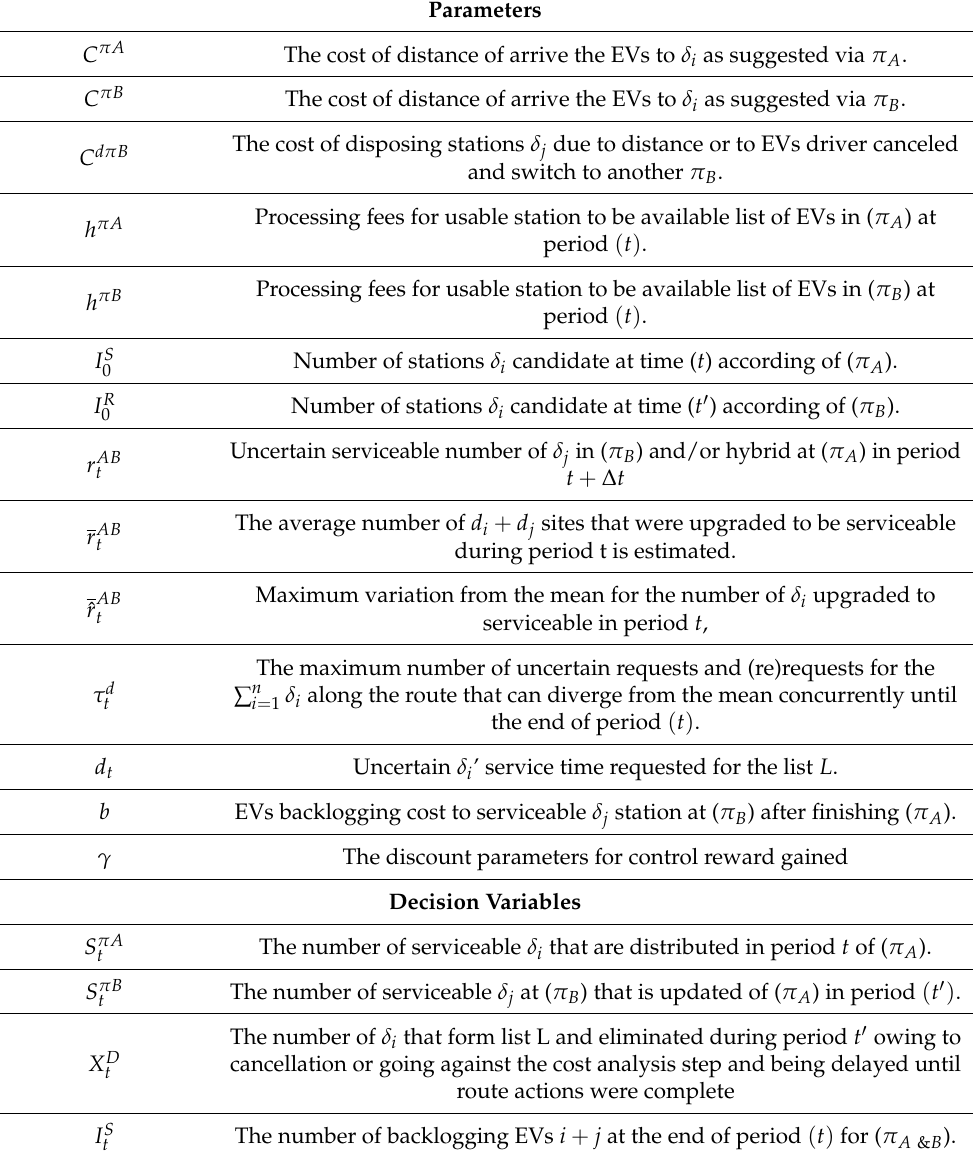
Table 3. The AIoT-DQN equations parameters and Decision